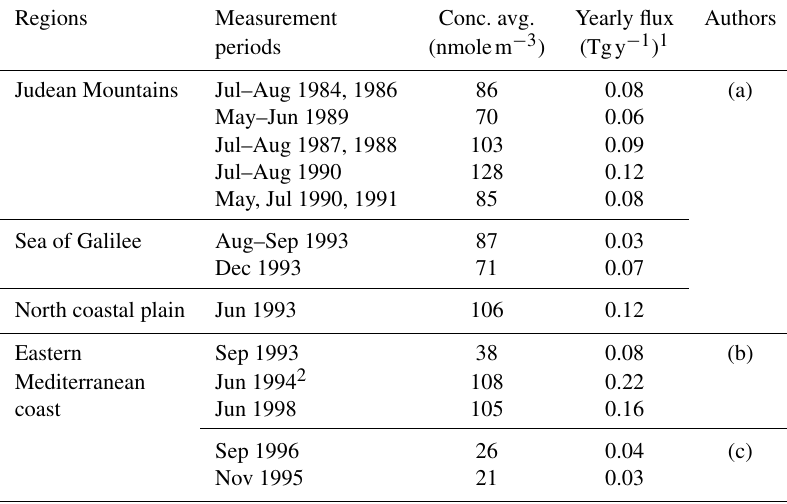
Table 2. Compilation by Rudich et al. (2008) of sulfate particulate concentrations and yearly fluxes from (a) Luria et al. (1996), (b) Wanger et al. (2000), and (c) Matvev et al. (2002). Regions